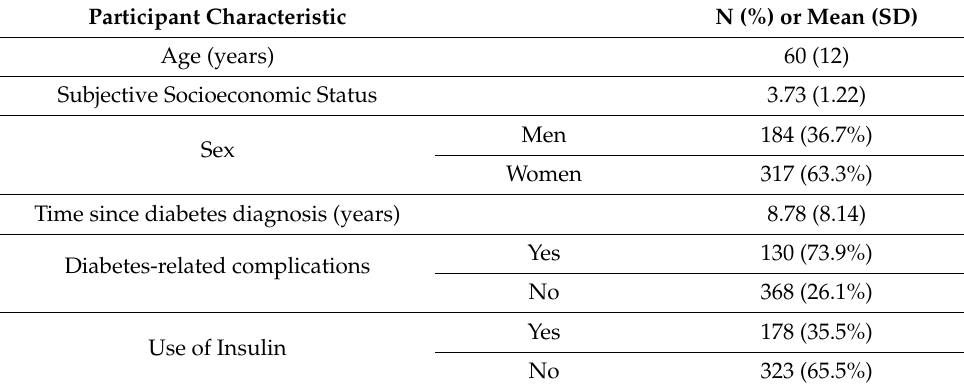
Table 1. Sociodemographic and clinical characteristics of participants (n =